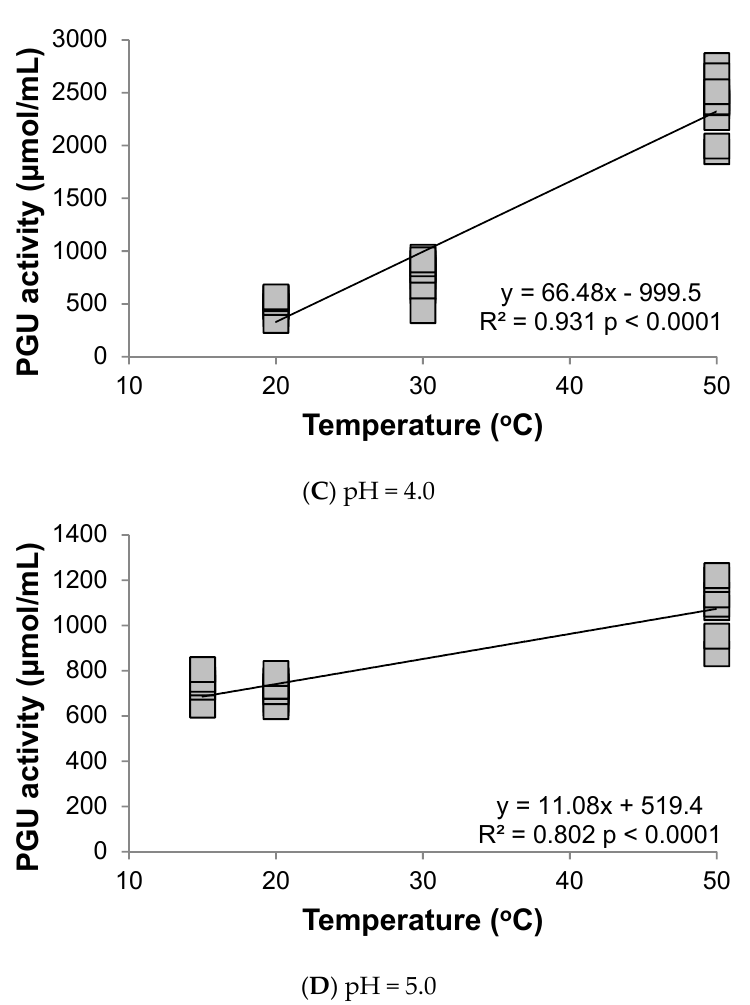
Figure 2. Impact of temperature on polygalacturonase (PGU) activity in Scottzyme Color X at four pH values; ethanol = 0%, measured in sodium acetate buffer solution.